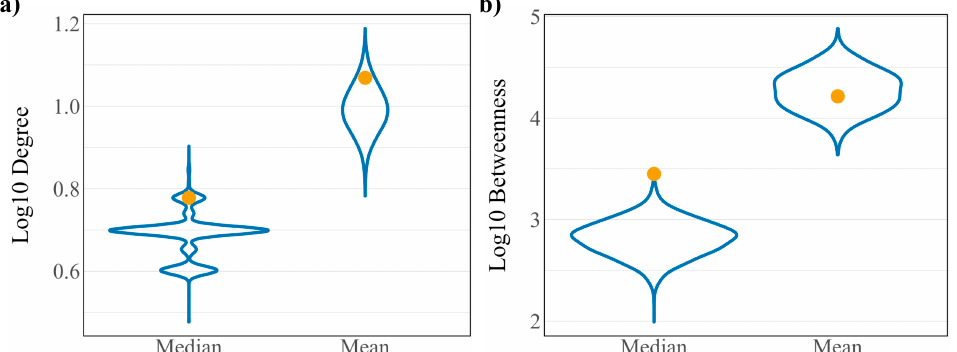
Figure 3. Distributions of ( a ) log 10 degree and ( b ) log 10 betweenness of 10,000 random “pseudo-virus interacting” protein sets. True values for virus interacting proteins are shown in yellow.